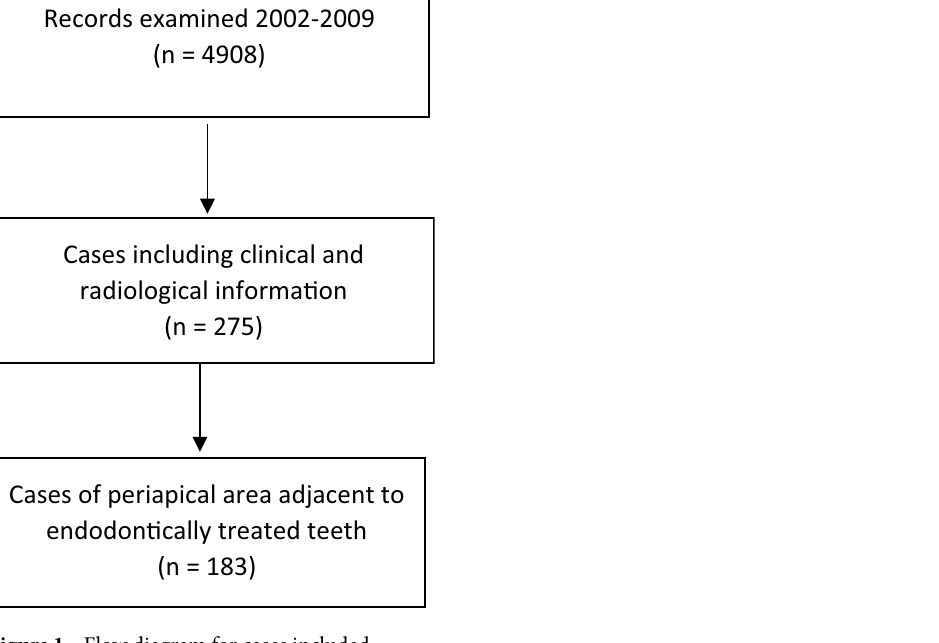
Figure 1. Flow diagram for cases